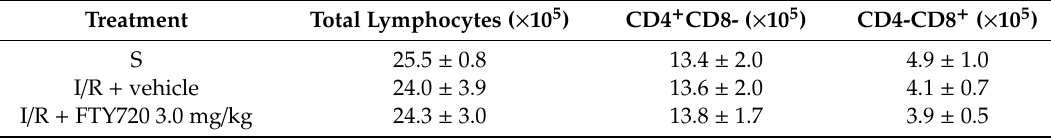
Table 2. Mesenteric lymph nodes (MLNs) lymphocytes count. Number of total lymphocytes, CD4 + CD8- and CD4-CD8 + T lymphocytes in MLNs excised from S mice and from I / R mice administered with vehicle or FTY720 3.0 mg / kg i.v. ( n = 5 independent values per group). Data are expressed as the mean value ±